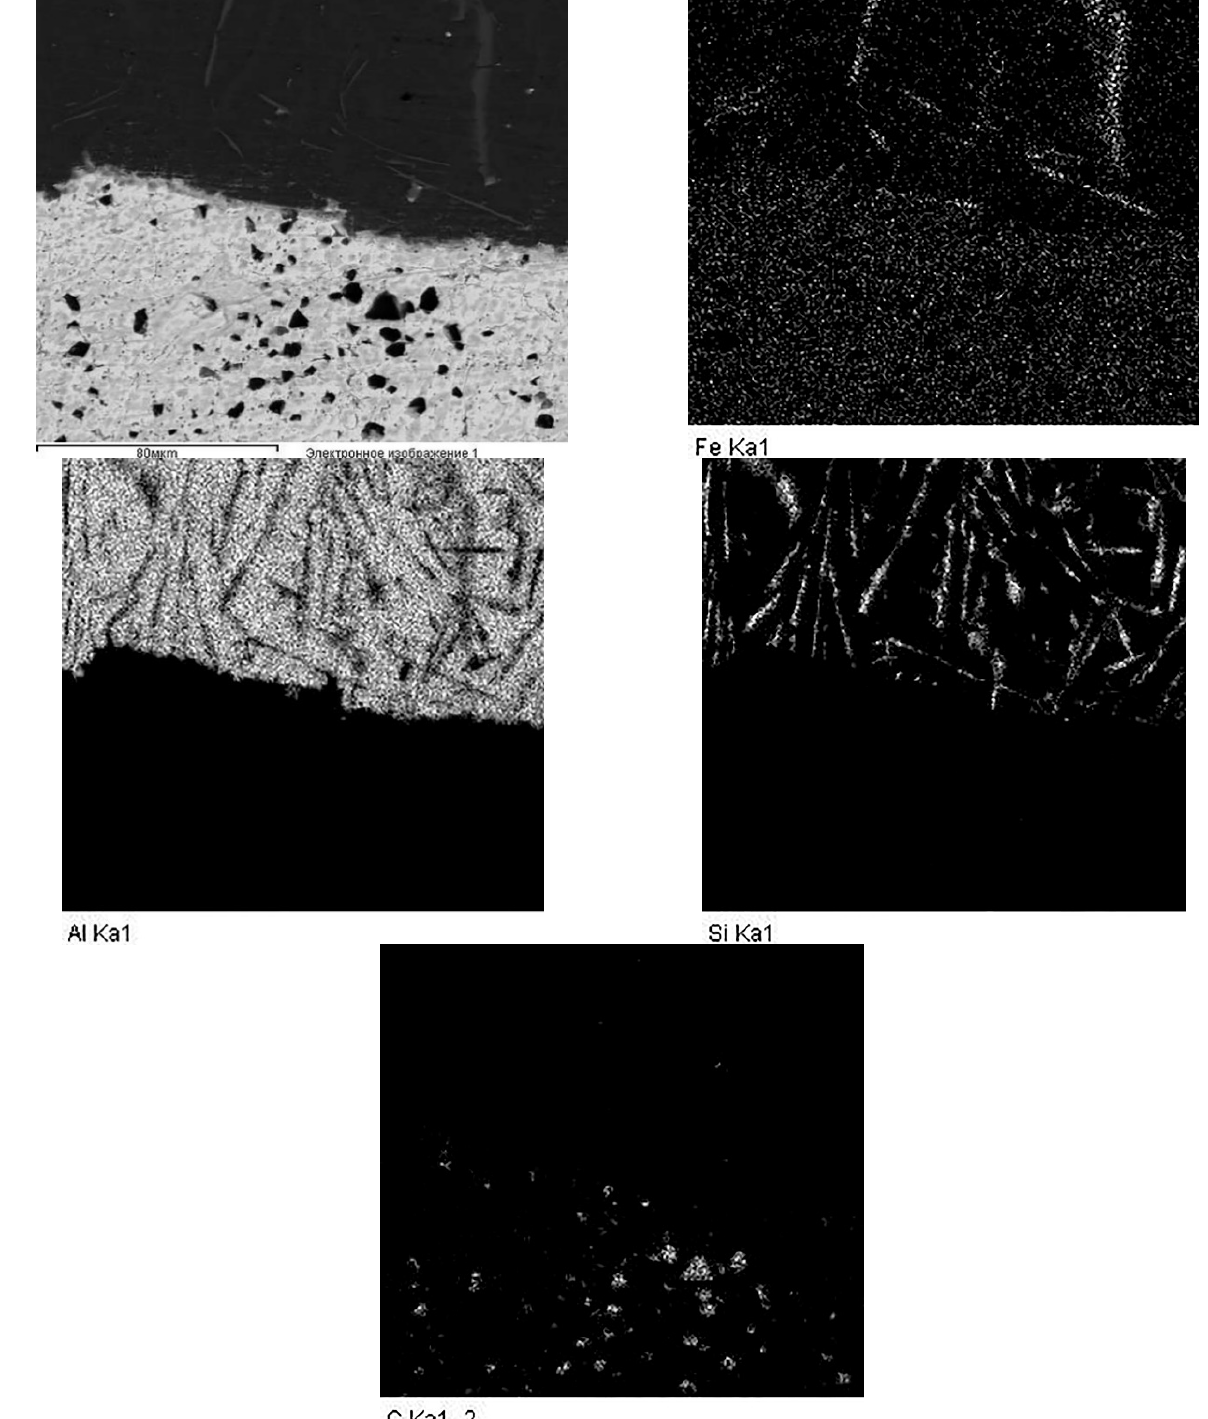
Figure 4. Elements distributed on maps in the deposited coating with the lead sublayer.